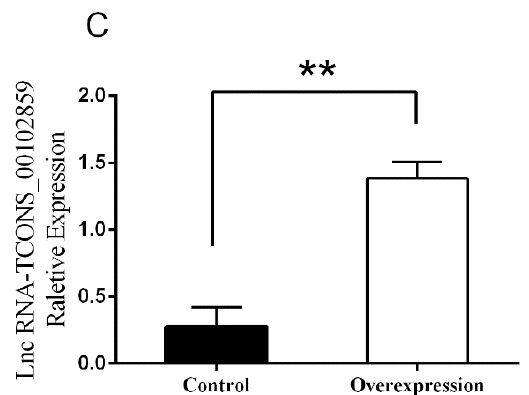
Figure 9. Fluorescence analysis of myoblasts cells transfected with lentiviral vectors (10×). ( A ) Positive cells were observed using a light microscope (10×). ( B ) Positive cells were observed using a fluorescence microscope (10×). ( C ) Expression level of TCONS_00102859 in myoblasts. The expression level of TCONS_00102859 in test group was significantly higher than that in control ( p < 0.01). ‘*’ represents significant difference ( p < 0.05) and ‘**’ represents extremely significant difference ( p < 0.01).